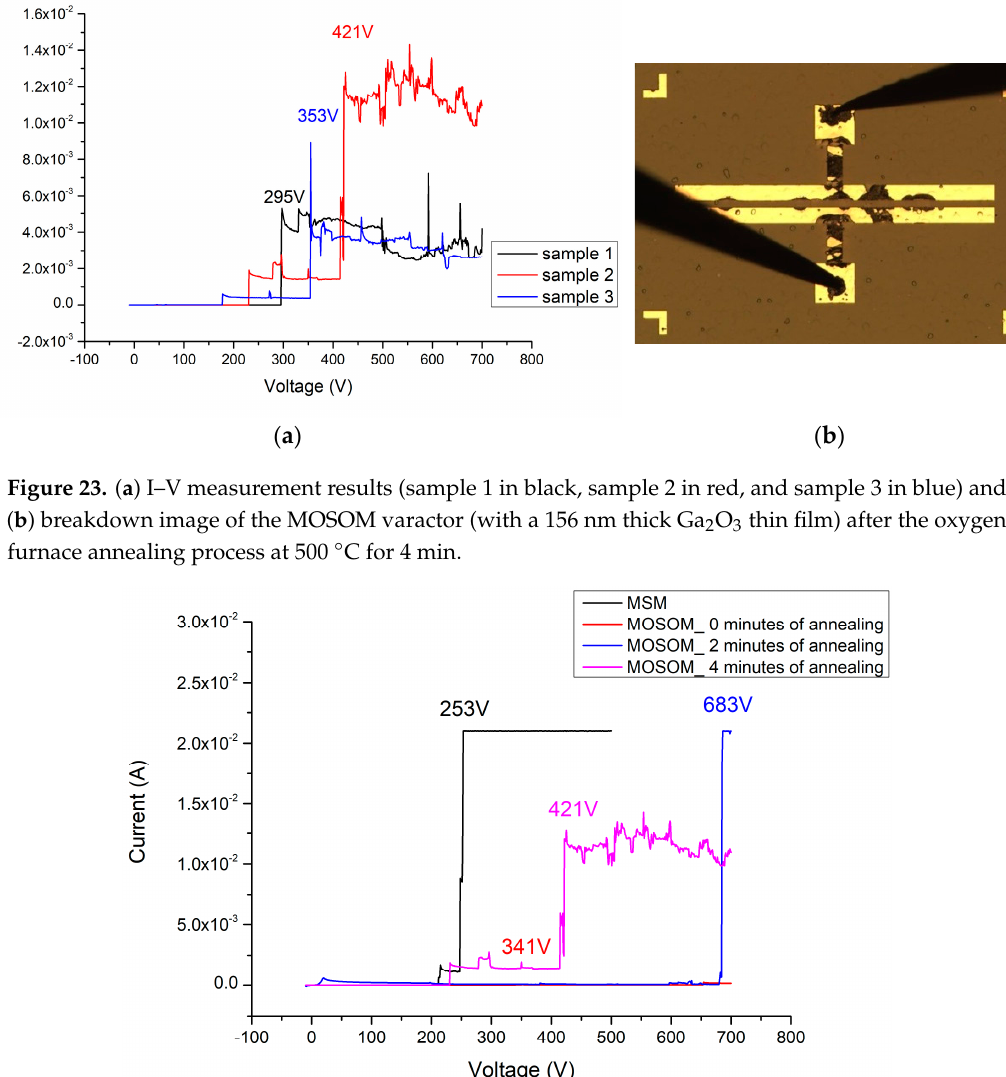
Figure 22. ( a ) I-V measurement results (sample 1 in black, sample 2 in red, and sample 3 in blue) and ( b ) breakdown image of the MOSOM varactor (with a 156 nm thick Ga 2 O 3 thin film) after the oxygen furnace annealing process at 500 °C for 2 min.